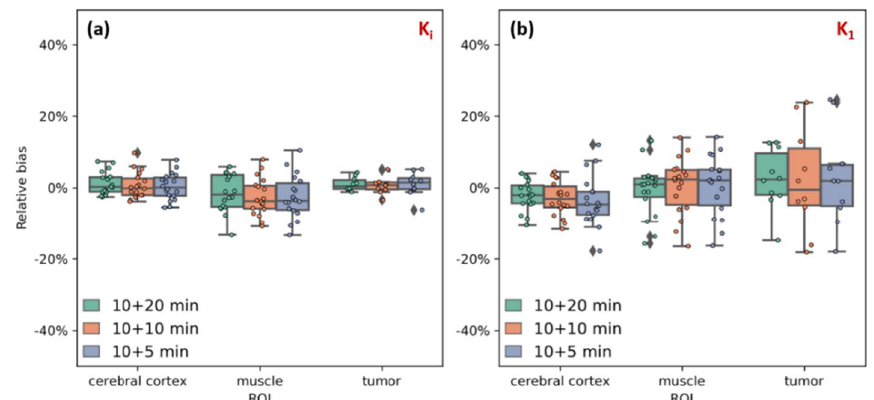
Fig. 5 Distribution of the percentage bias in K i ( a ) and K 1 ( b ) derived from the DTW